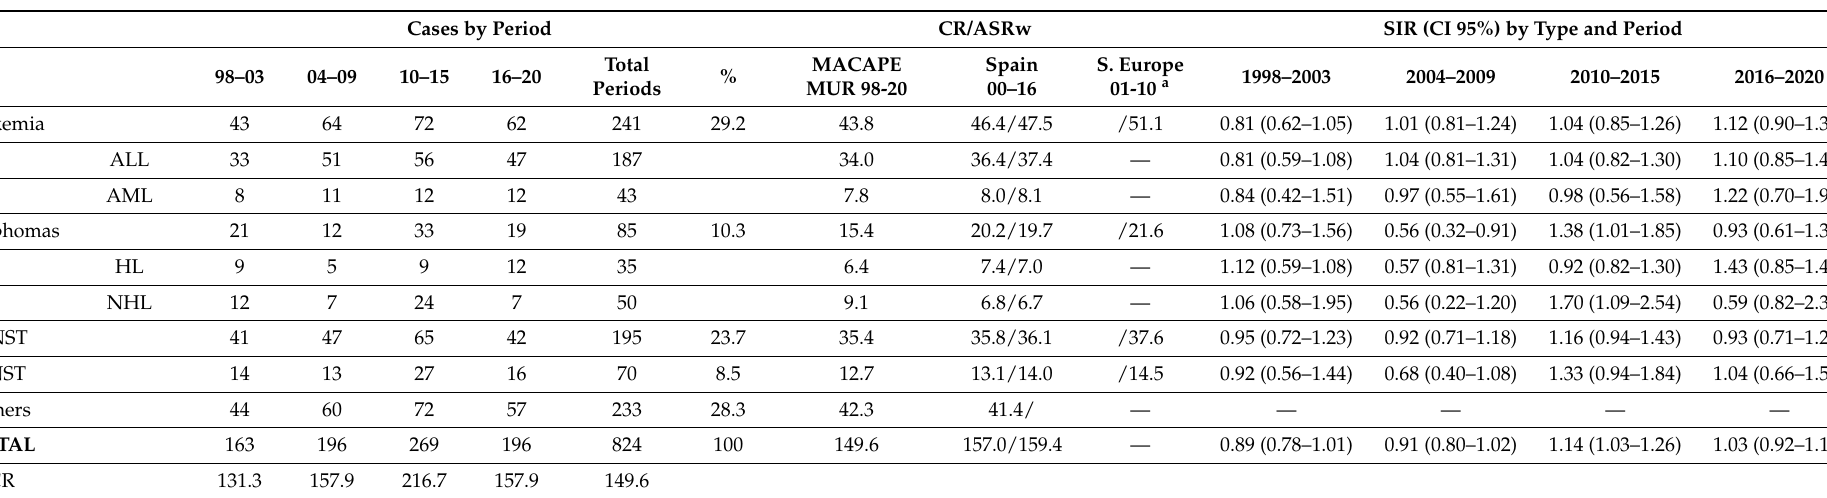
Table 3. Distribution of childhood cancer in the region of Murcia (1998–2020). Crude rate and standardized incidence ratio by tumor type and time cohort (n = 822). Cases by Period